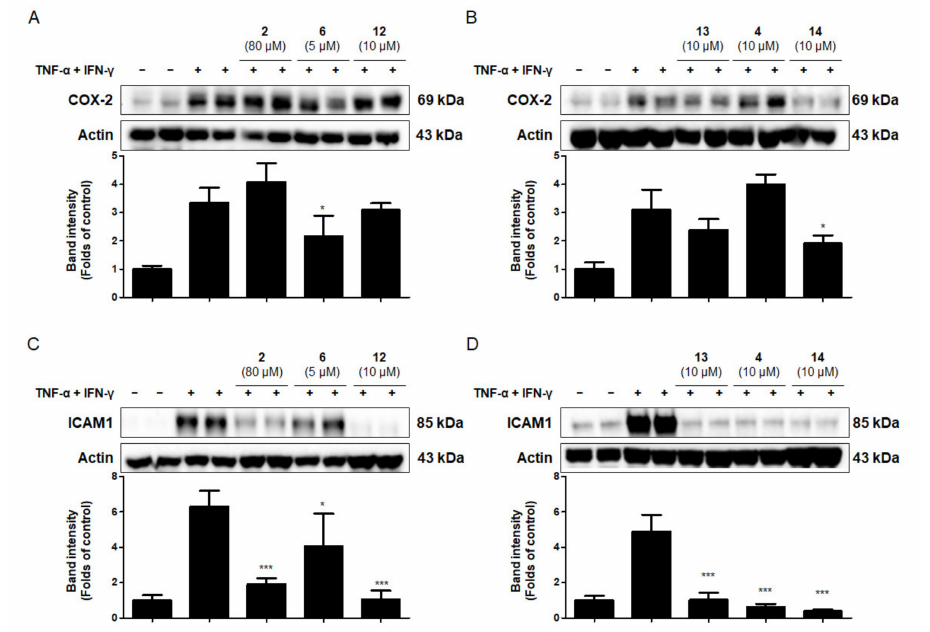
Figure 4. Protein expression levels of COX-2 ( A , B ) and ICAM-1 ( C , D ) in TNF- α + IFN- γ -treated HaCaT cells. ( A , B ) Cells were pretreated with the six compounds from C. tricuspidata at the indicated concentrations for 3 h and stimulated with TNF- α + IFN- γ (20 ng/mL) for 24 h. ( C , D ) Cells were pretreated with the six compounds from C. tricuspidata at the indicated concentrations for 3 h, and then stimulated with TNF- α + IFN- γ (20 ng/mL) for 6 h. Western blotting analysis was performed as described in the Materials and Methods section. Representative stains from four independent experiments are presented. The immunoblot was quantified using ImageJ software. The band intensity was normalized to that of actin. * p < 0.05, *** p < 0.001 compared with TNF- α + IFN- γ only. COX-2, cyclooxygenase-2; ICAM-1, intercellular adhesion